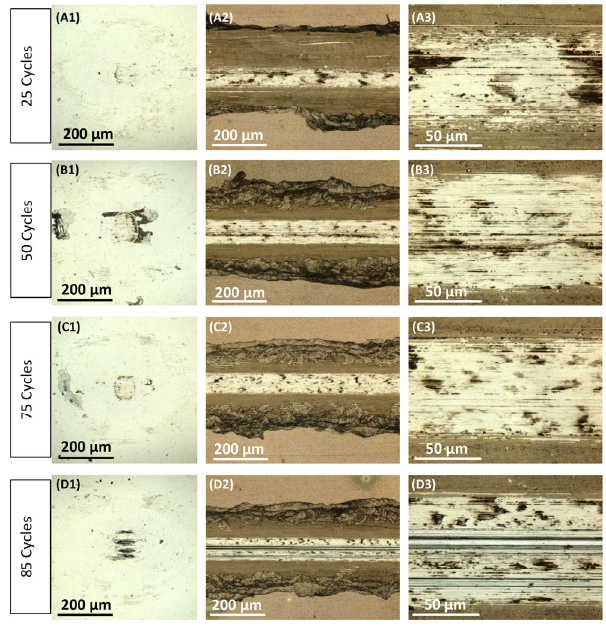
Fig. 13 Optical images of the counterface balls and wear tracks: (A1)–(D1) counterface balls and (A2)–(D2) wear tracks after progressive test on the PDA/PTFE coatings on smooth stainless steel. (A3)–(D3) are zoom-in images of (A2)–(D2).